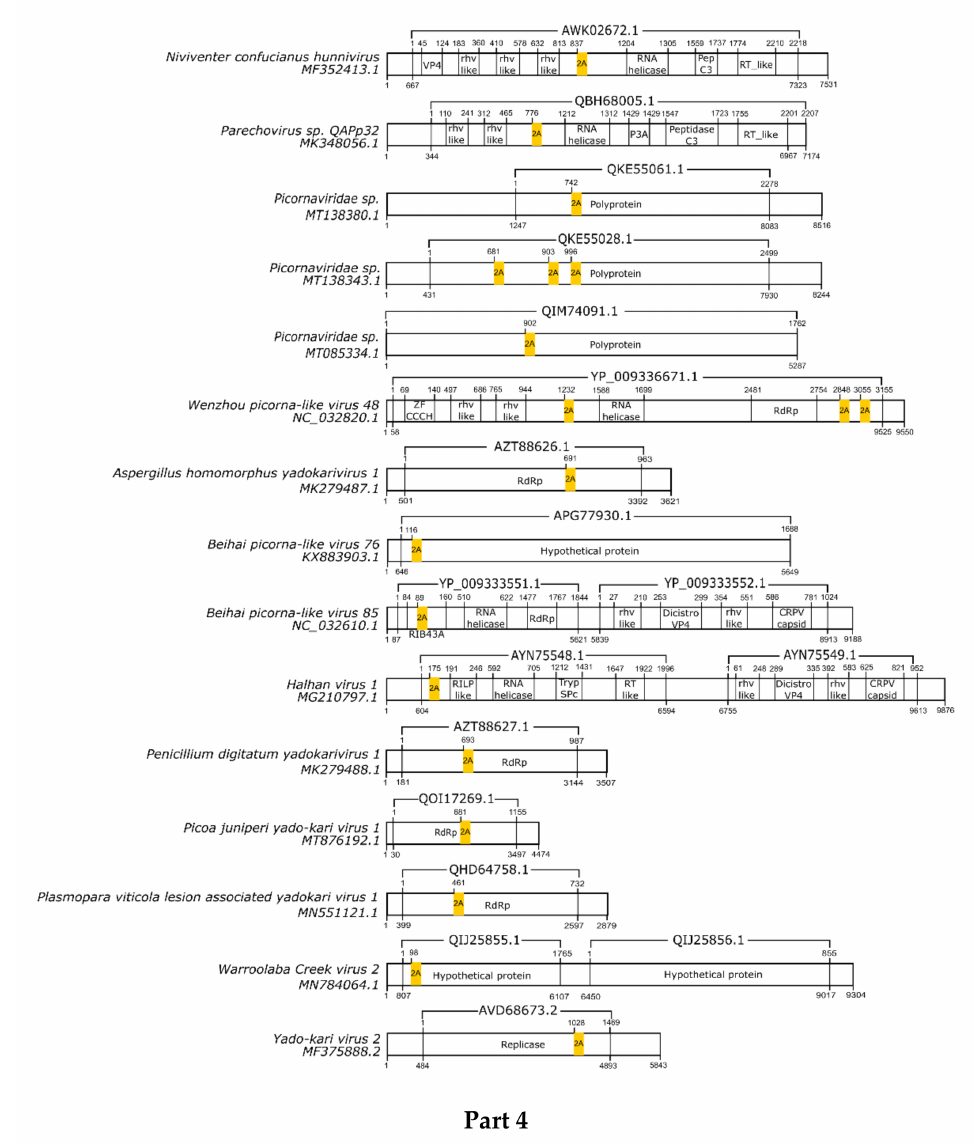
Figure 1. Schematic representation of positive-sense single-strand RNA virus sequences. Schematic representations of pssRNA virus sequences showing the location of each respective 2A-like (yellow rectangles). The nucleotide positions and size of each predicted polypeptide are represented by the numbers below and above the bars, respectively. The annotations of each viral sequence were included according to the NCBI. The nucleotide and protein accession numbers are presented forward and above each scheme, respectively. Representations of each genome are not in scale. This figure is presented in four